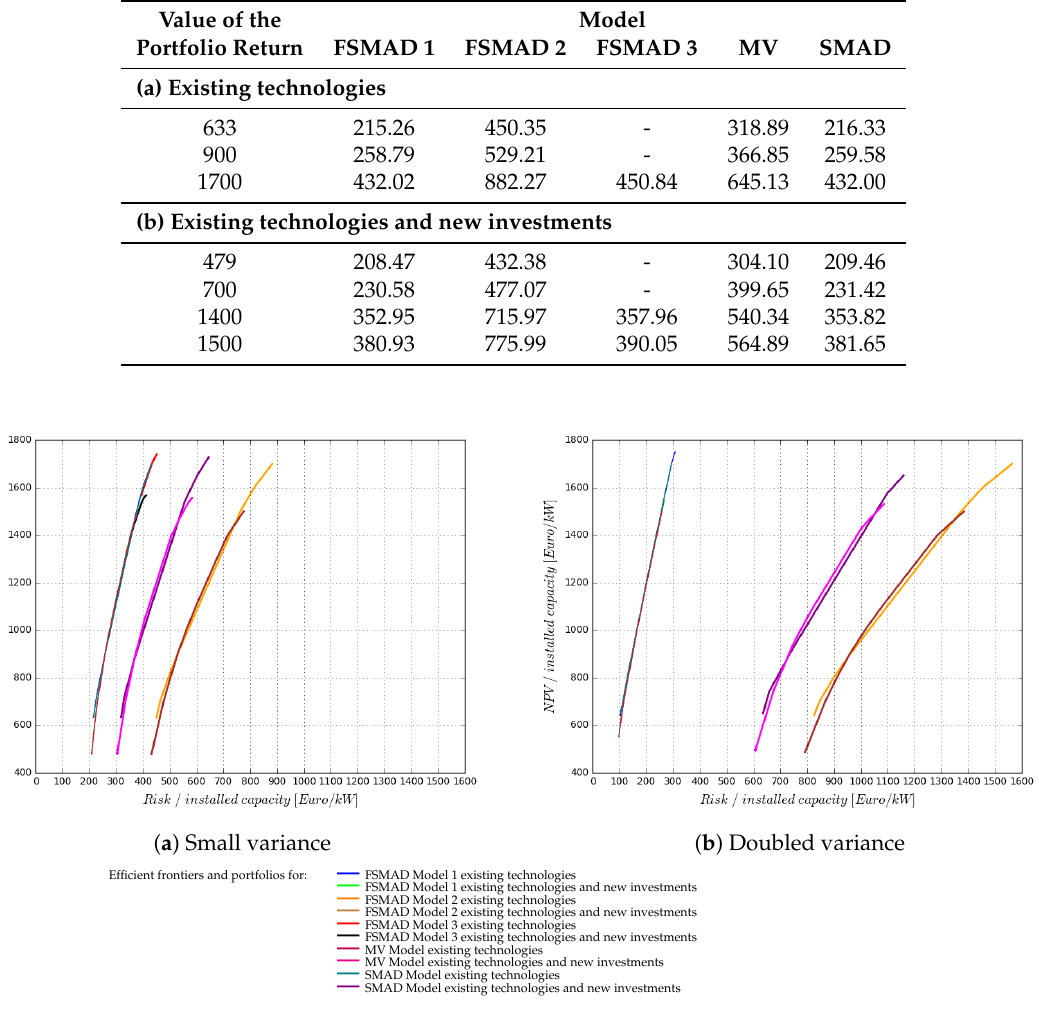
Figure 4. Comparison of the efficient frontiers obtained with all models